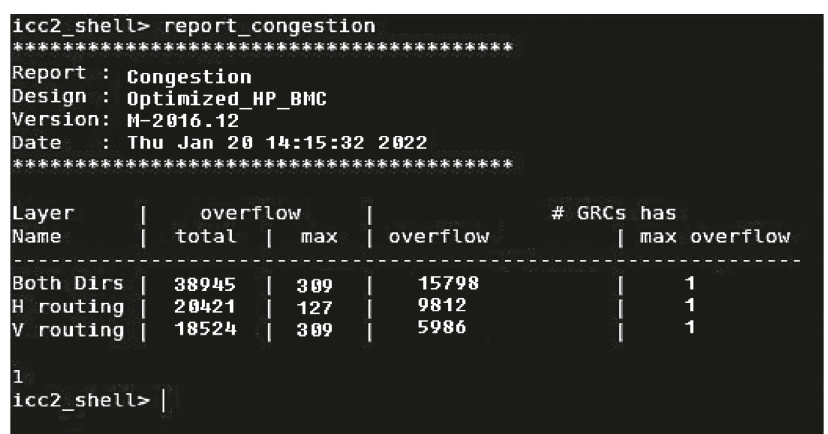
Figure 5: Simulation report before Perimeter Degree Congestion